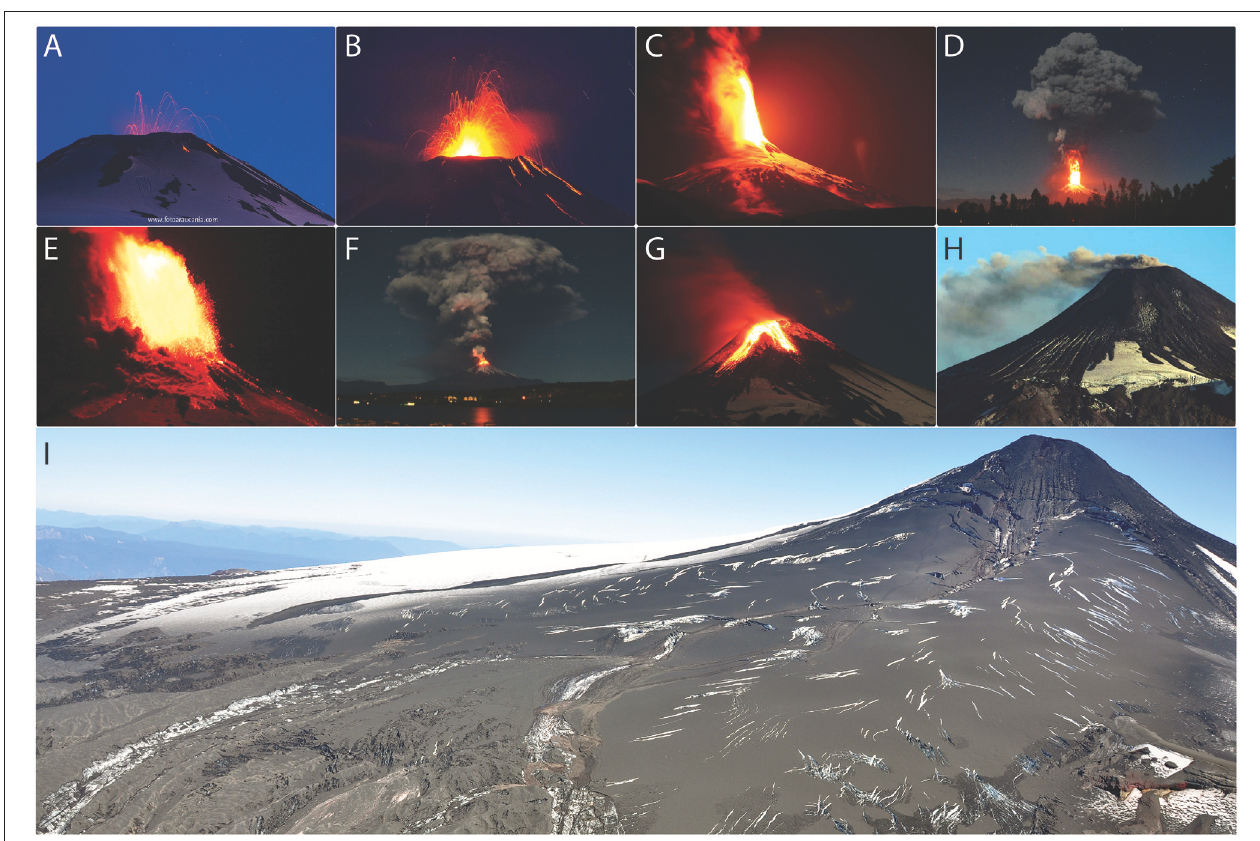
FIGURE 2 | Chronology of the 3 March 2015 lava fountain episode. (A) Strombolian activity on 20 February 2015 (Diego Spatafore). (B) A rising of the lava lake level produced increased Strombolian activity on 3 March 2015 (Martini Fotografia). (C) Lava fountain activity since 03.08 local time on 3 March. (D) Paroxysmal tephra column at 03.20 local time (Nicolás Gallo). (E) Reduction of the lava fountain height at 03.22 local time. (F) Tephra column at 03.22 local time (José Rodríguez). (G) Clastogenic lavas seen after the end of the paroxysmal eruption. (H) Aspect of the mixed avalanche deposits and ash emissions on 18 March 2015. (I) Tephra fall deposit on the east-southeast flank of the volcano on 3 March (Daniel Basualto). Pictures (C , E , G , H) taken by Anselmo